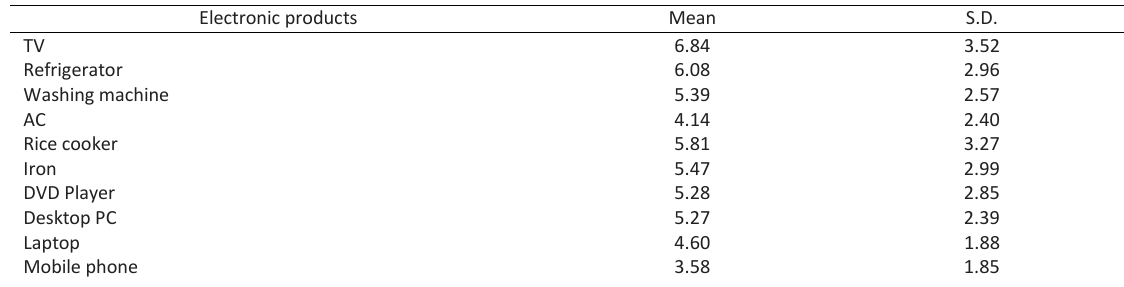
Table 1: Products lifespan (year)